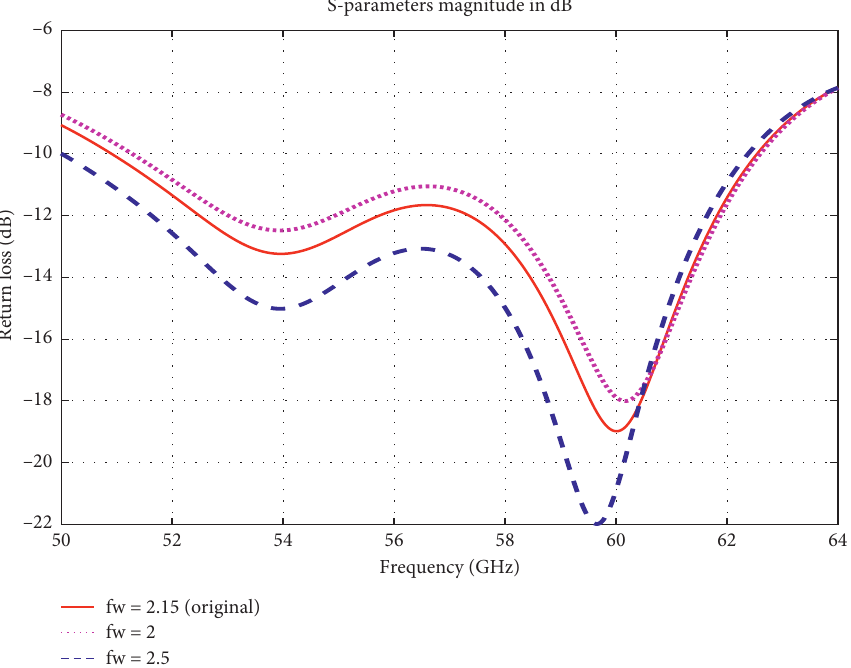
Figure 6: Return loss for different feedline widths.